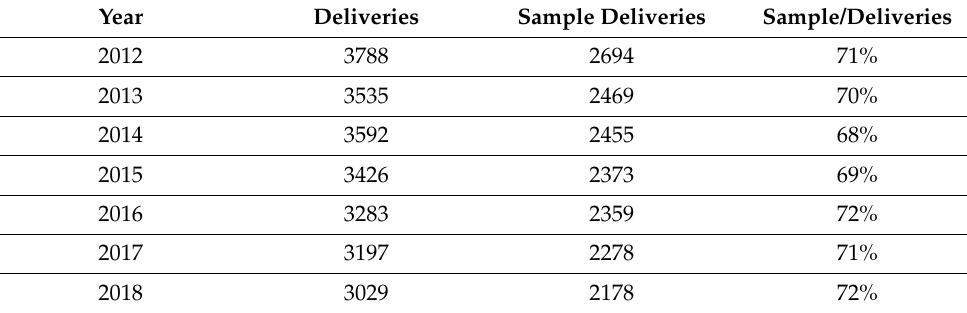
Table 1. Number of births registered in the Lleida health region by years and number of births in the sample studied with the percentage they represent. Data were collected from IDESCAT. Year Deliveries Sample Deliveries Sample/Deliveries 2012 3788 2694 71% 2013 3535 2469 70% 2014